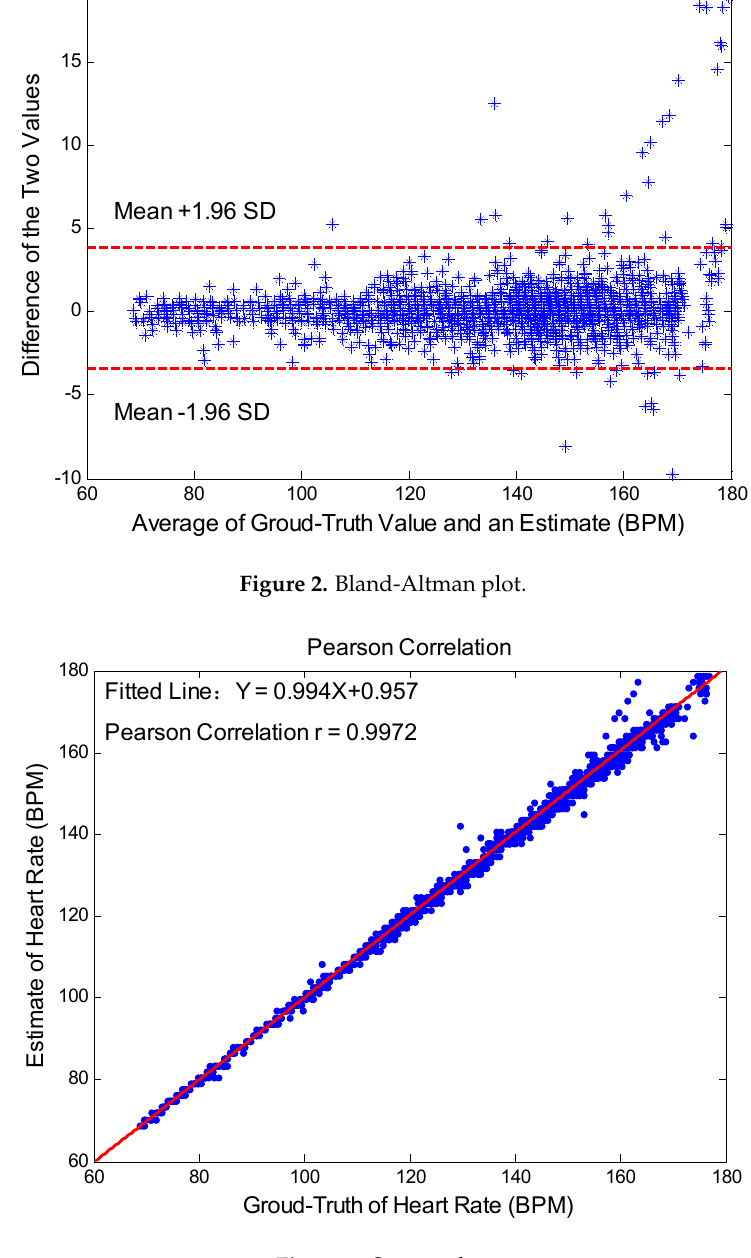
Figure 3. Scatter plot. Figure 3. Scatter